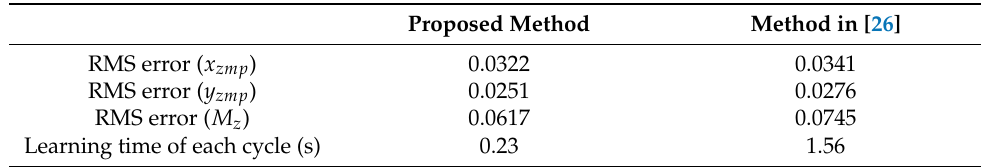
Table 2. Comparison of control